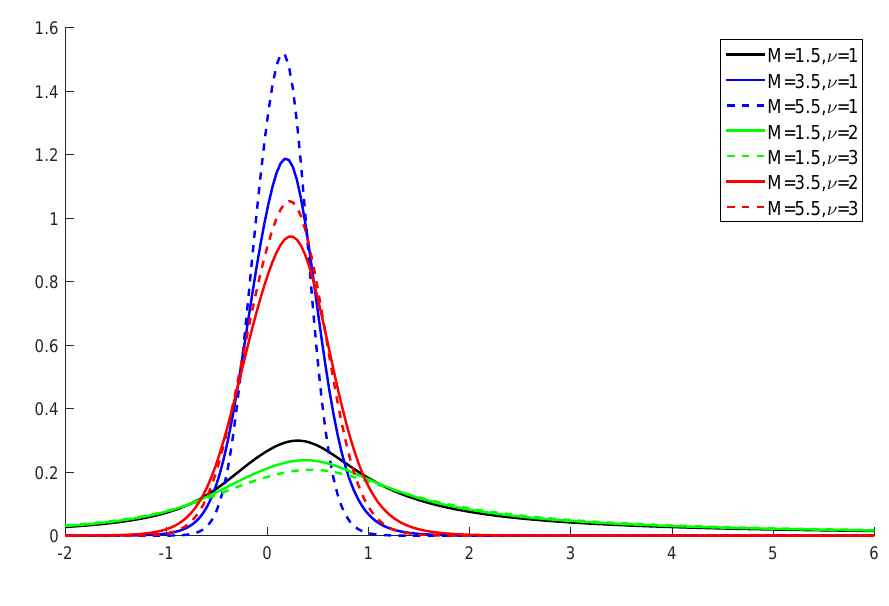
Figure 4: Pdf of the third order statistic from l 4,3 -symmetric sample vector distribution, f 3:4 , if the dg is g (4)